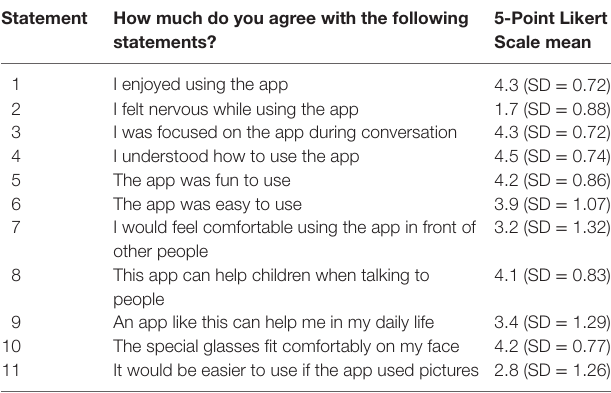
Table 2 | User satisfaction Likert Scale results.